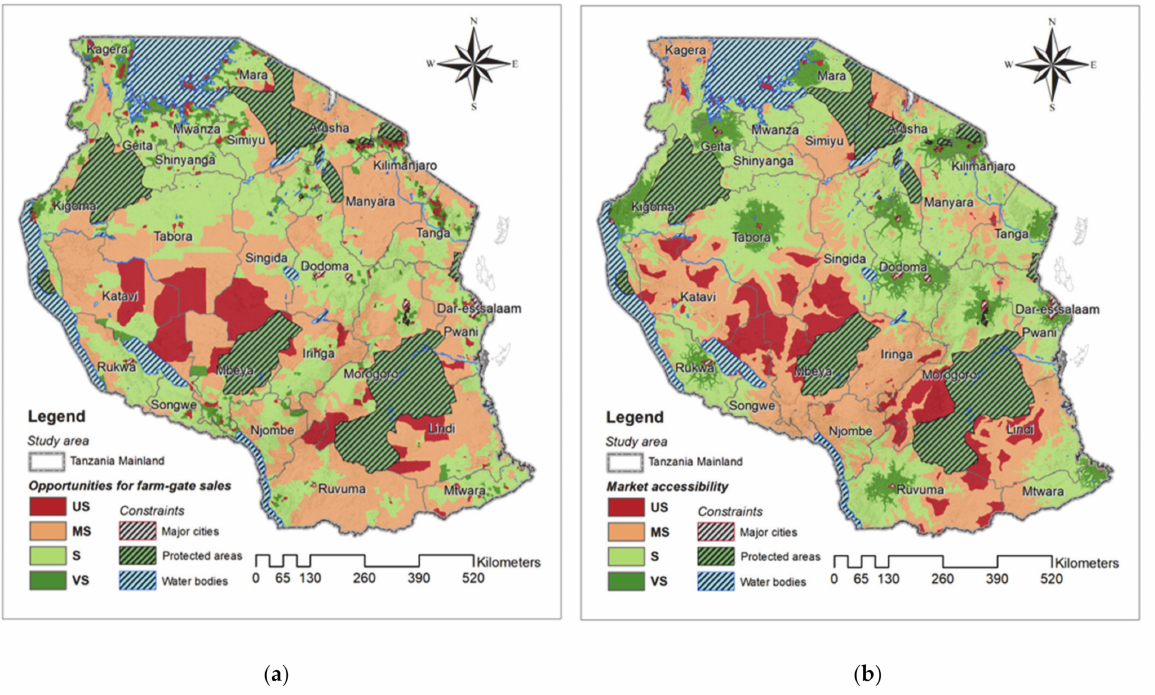
Figure 10. The distribution of suitability scores for ( a ) farm-gate sales and; ( b ) market accessibility.